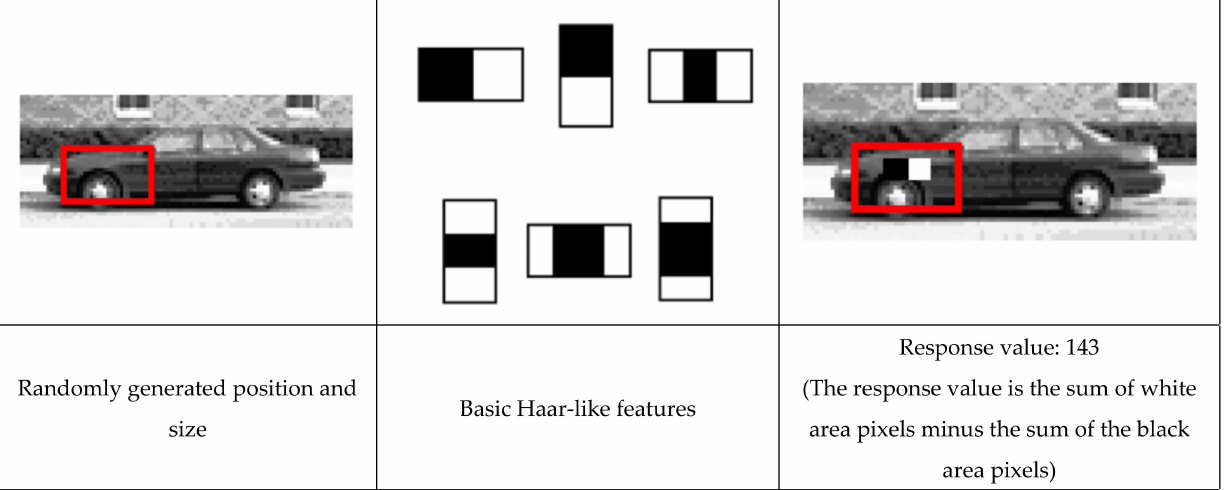
Figure 6. Feature extraction process of Haar-like.